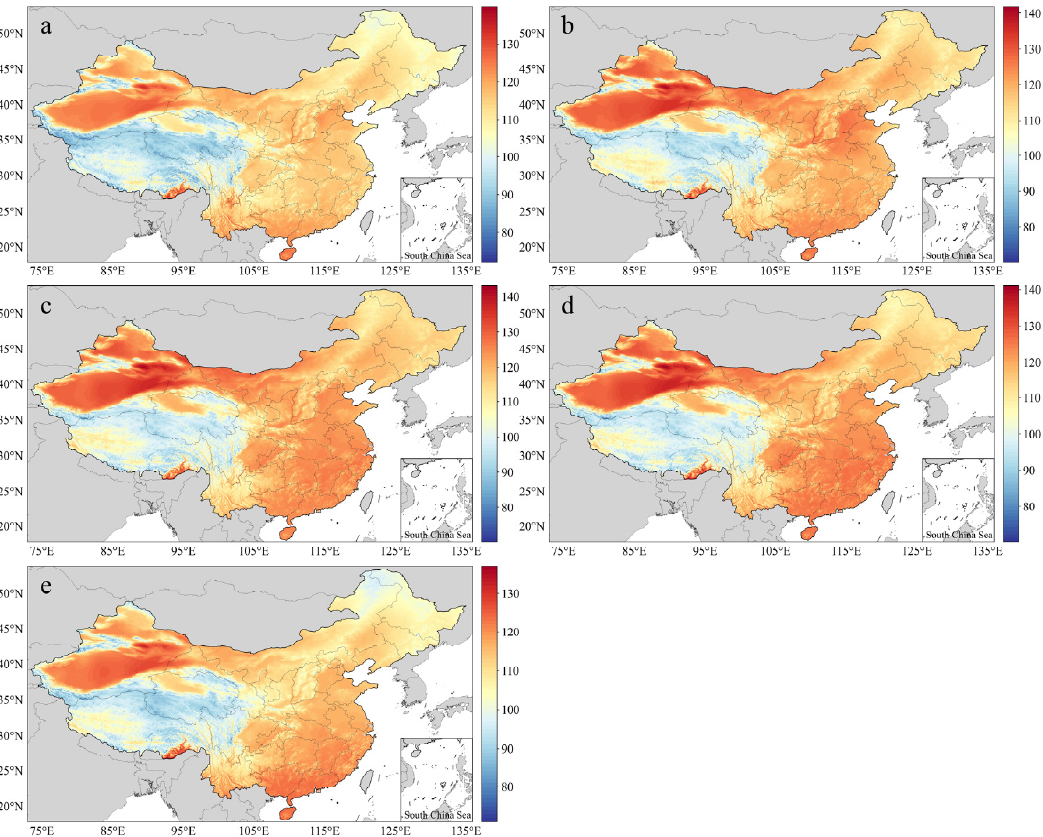
Figure 3. Spatial distribution of annual average TI (ATI) values for the years 1990–2019: ( a ) May, ( b ) June, ( c ) July, ( d ) August, ( e ) September. With the time series as the independent variable and the ATI of each month over 30 years as the dependent variable, linear regression was carried out and the change slope was calculated, with a significance test performed. Figure 4 shows the ATI slopes for